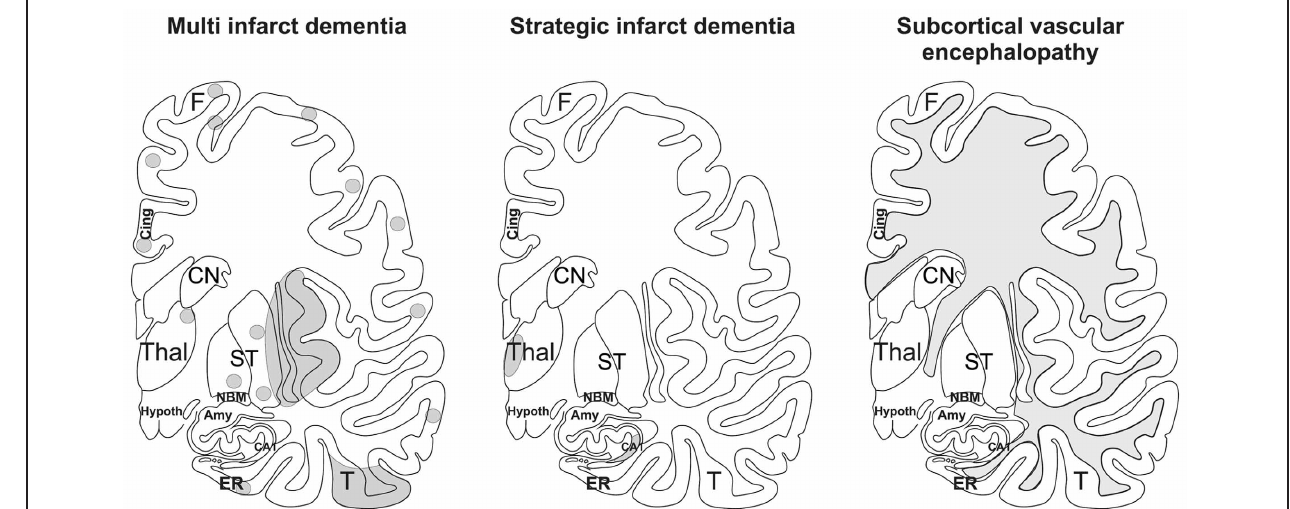
FIGURE 2 | Schematic representation of multi infarct dementia, strategic infarct dementia, and subcortical vascular encephalopathy. The gray areas mark the regions where infarcts and white matter lesions are located. In multi infarct dementia multiple microinfarcts, lacunar infarcts, and small large infarcts are distributed all over the gray matter. Strategic infarct dementia is characterized by infarcts in strategic regions that alone explain dementia, i.e., in the hippocampal formation and in the paramedian nuclei of